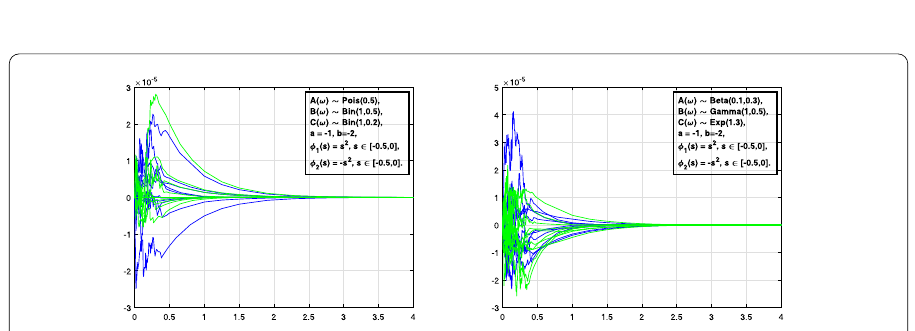
Figure 12 Ten stable solutions for each process x 1 ( t ) and x 2 ( t ) of (39)